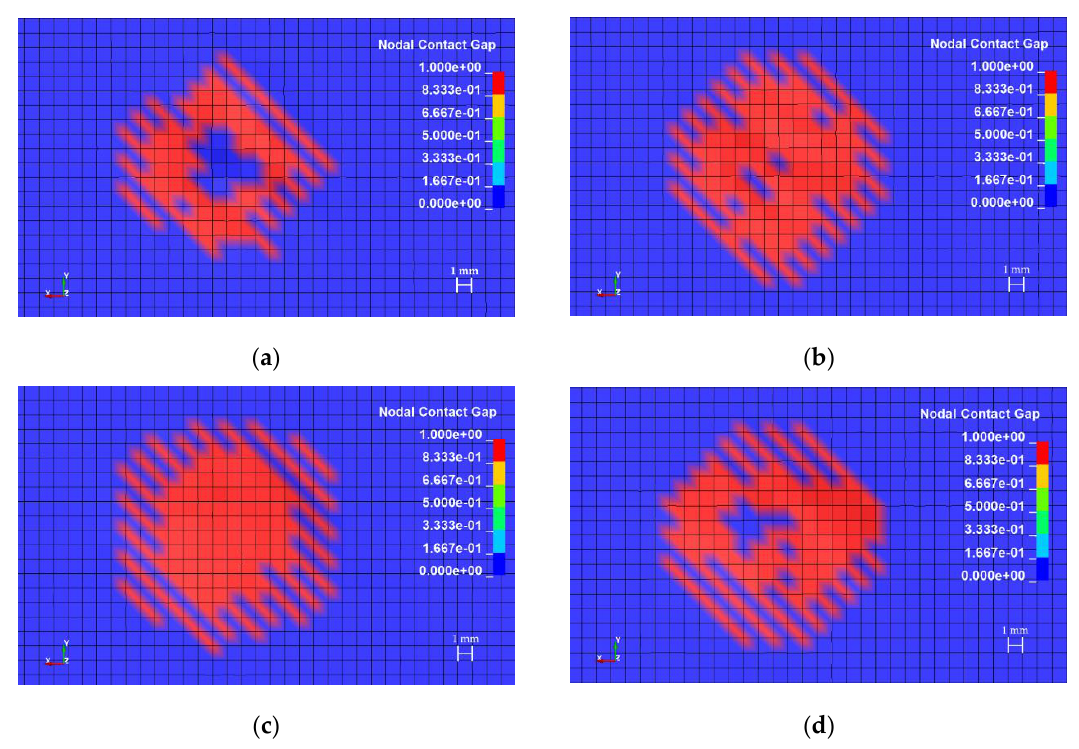
Figure 15. Colored maps of delamination areas after impact of the blunt striker between layers: ( a ) 1 and 2, ( b ) 2 and 3, ( c ) 9 and 10, ( d ) 13 and